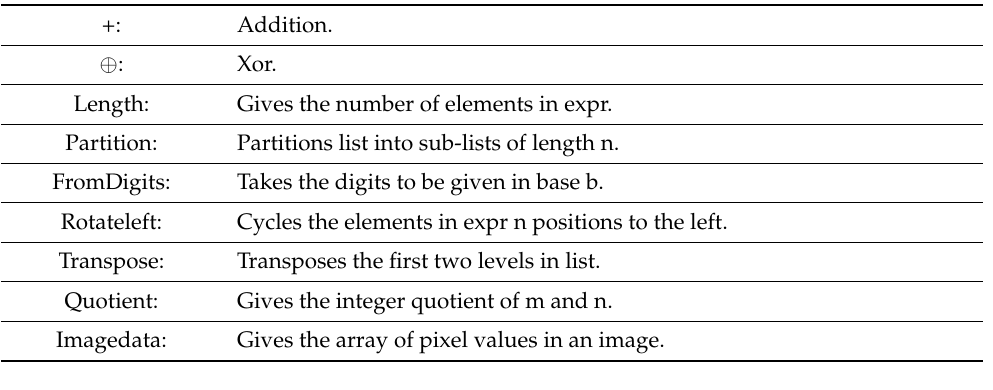
Table 1. List of mathematical symbols.